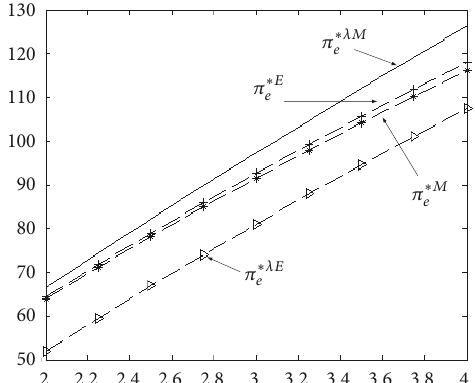
Figure 4: Change rule of sales price as 𝜌 changes.